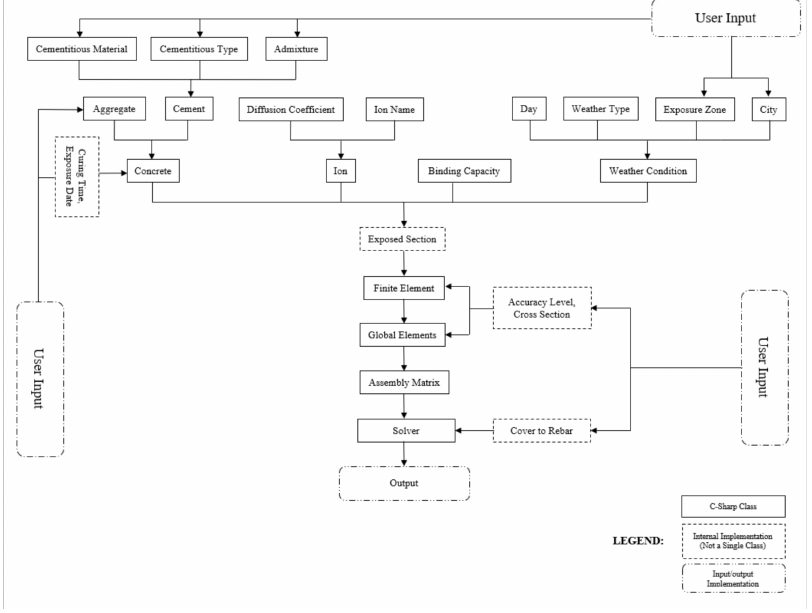
Figure 11. Class diagram / software implementation